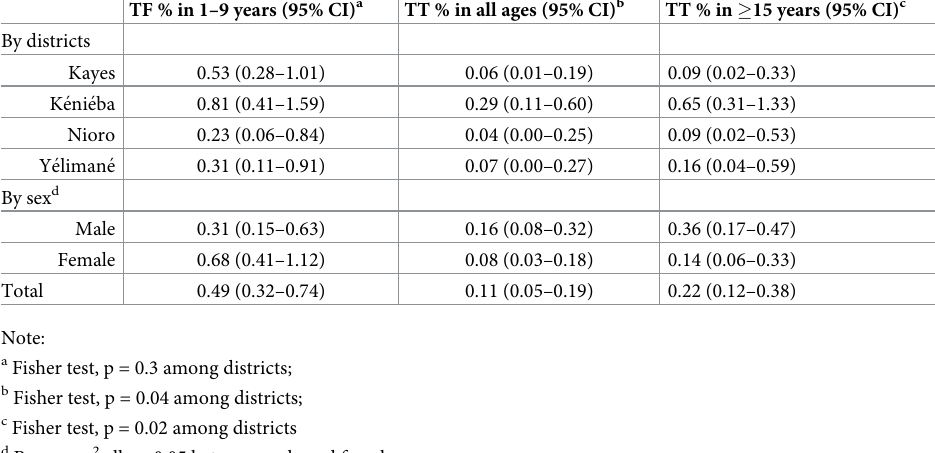
Table 2. Prevalence of active trachoma (TF) and trichiasis (TT) in four districts in Kayes region in